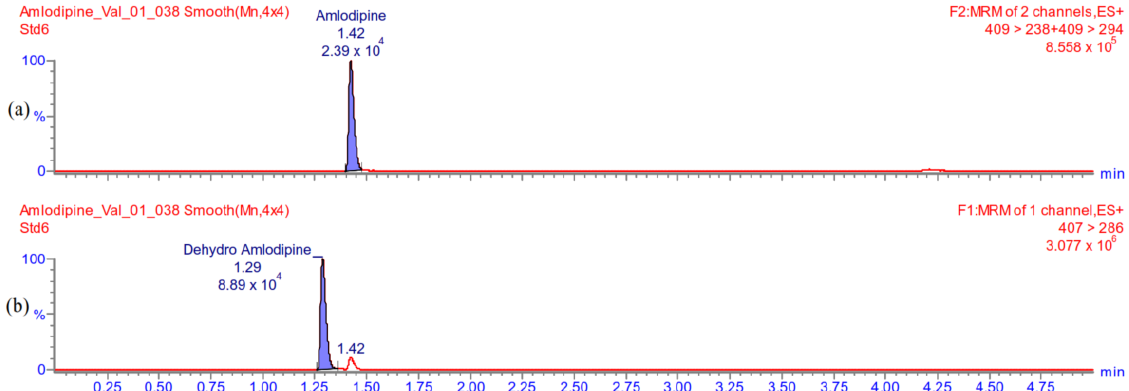
Figure A5. Chromatograms of highest plasma calibration standard 50.0 ng/mL. ( a ) AML and ( b ) DAML.